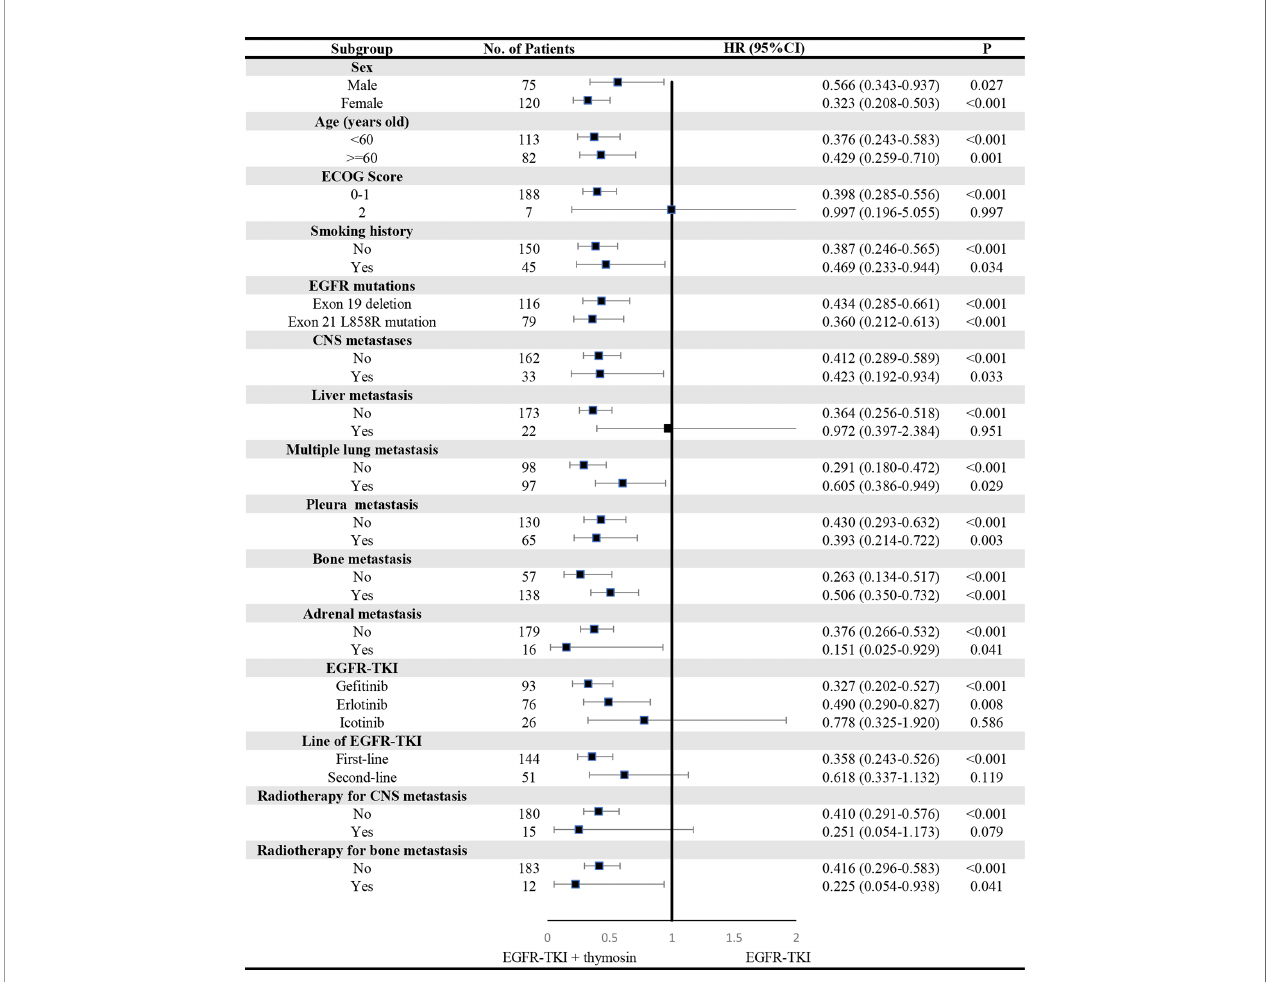
FIGURE 3 | Subgroup Analyses of Overall Survival. P showed the signi fi cance of the HRs. It was used to test the signi fi cance of OS between EGFR-TKI plus thymosin group and EGFR-TKI group in a certain variable. HR, hazard ratio; CI, con fi dence interval. ECOG, eastern cooperative oncology group; CNS, central nervous system.